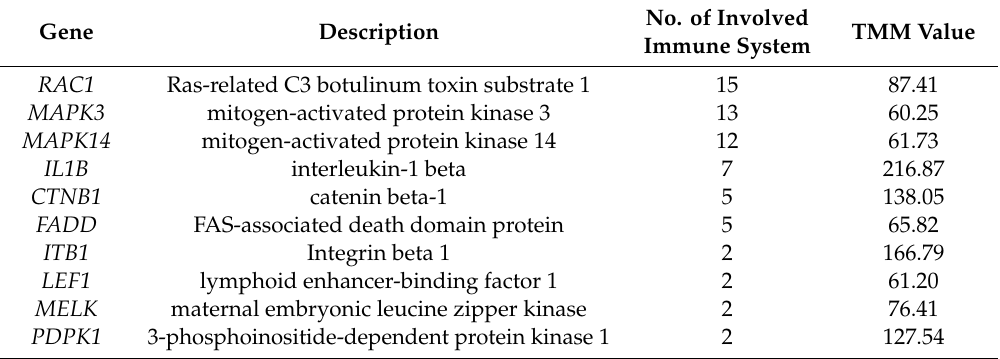
Figure 5. Identification of maternal immune-related gene transcripts based on GO and KEGG pathway annotations: ( a ) Distribution of maternal gene transcripts in the immune system process (GO:0002367) at GO level 3 and ( b ) distribution of maternal gene transcripts in the immune system pathway subcategories. Table 2. Maternal genes involved in multiple immune systems with high expression levels (TMM value >